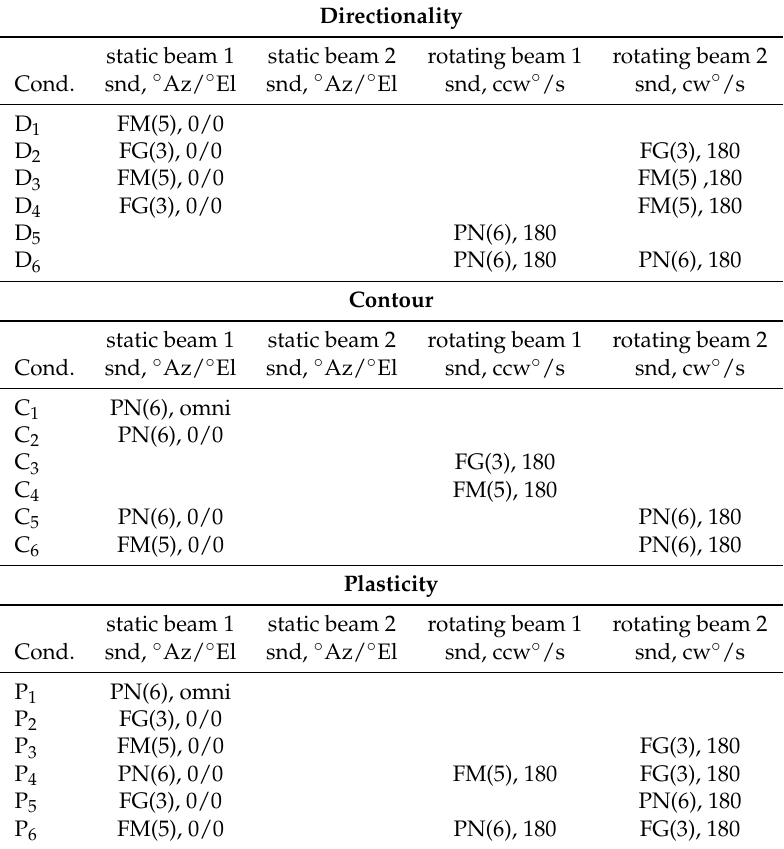
Table 2. Description of the conditions of experiment 2, their sound material (as described in Section 2.1), and beam direction/rotation parameters. Beams use 3rd-order unless otherwise